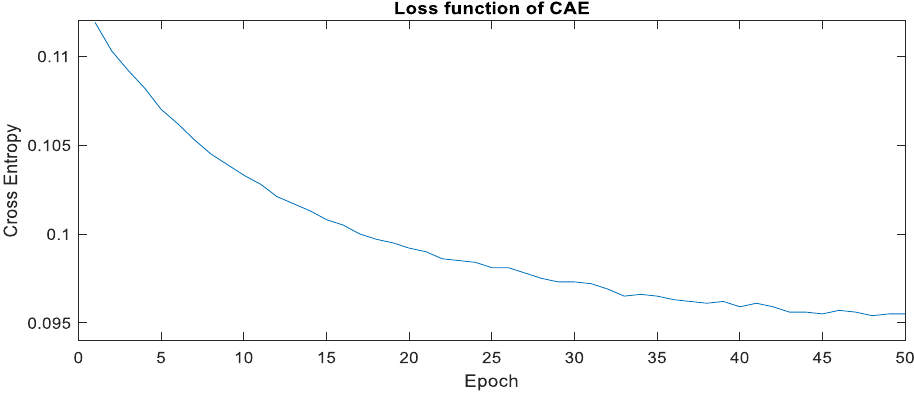
Figure 3. The training process of CAE.